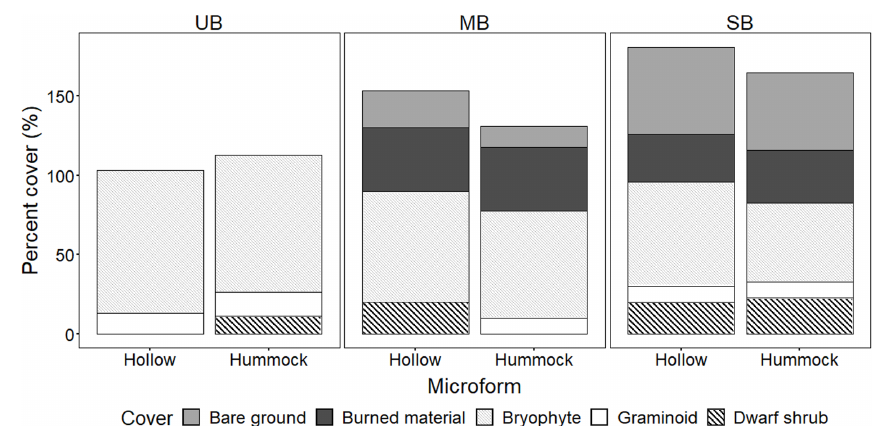
Figure 1. Vegetation cover (%) for each dominant plant functional type and ground cover for the flux collars in 2018 across the peat burn severity gradient.